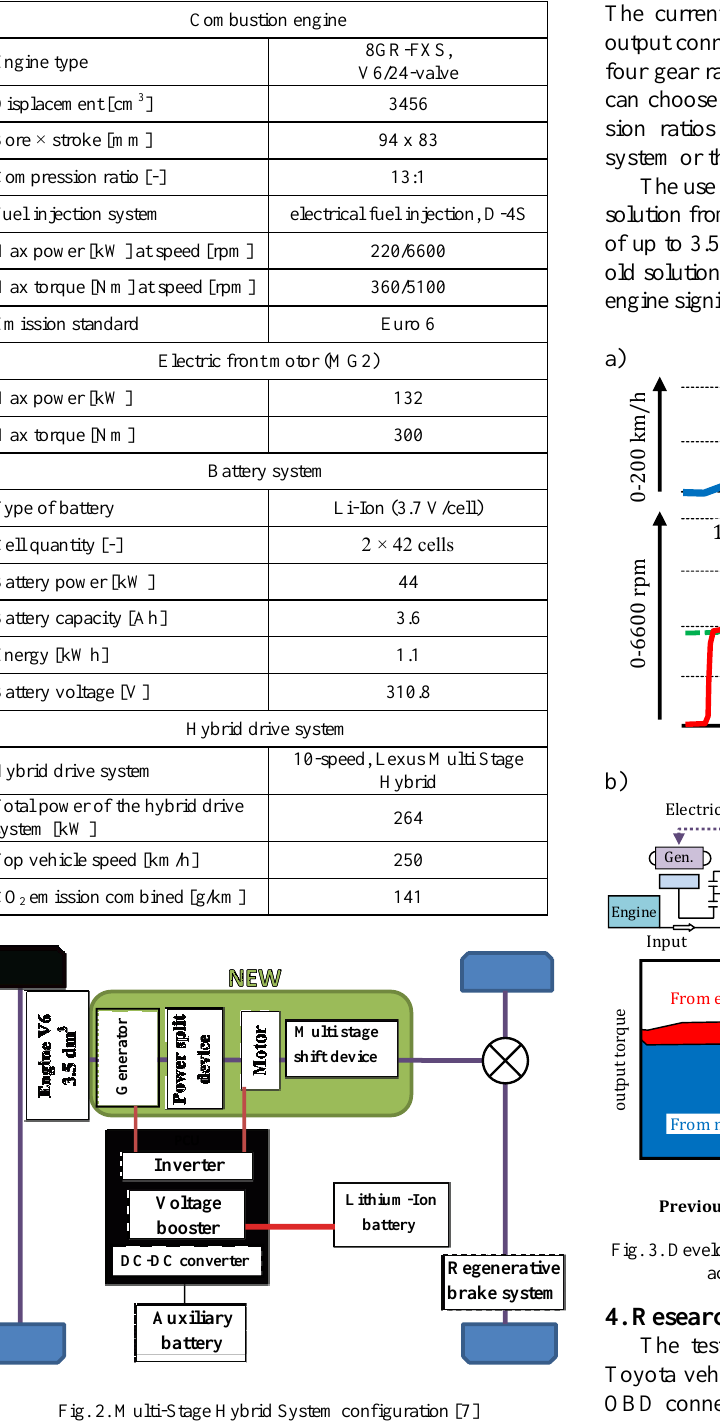
Table 1. Test vehicle technical data [14]